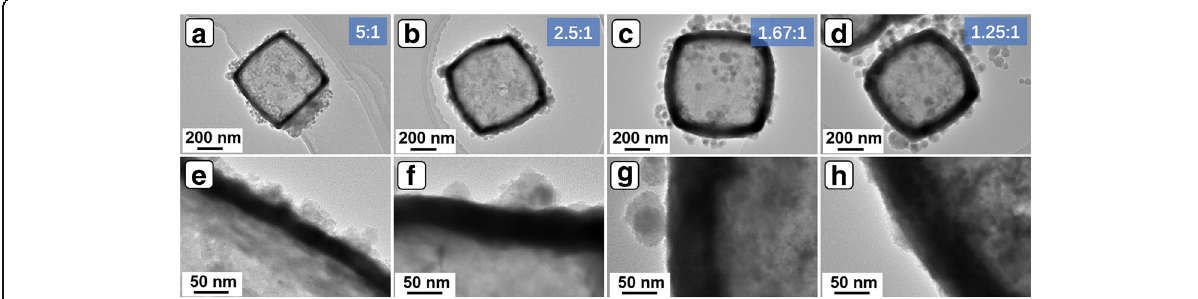
Fig. 5 a – d TEM images of the Ni(OH) 2 NCs obtained with different mass ratio of Cu 2 O/NiCl 2 . e – h TEM images of the corresponding shells of a – d